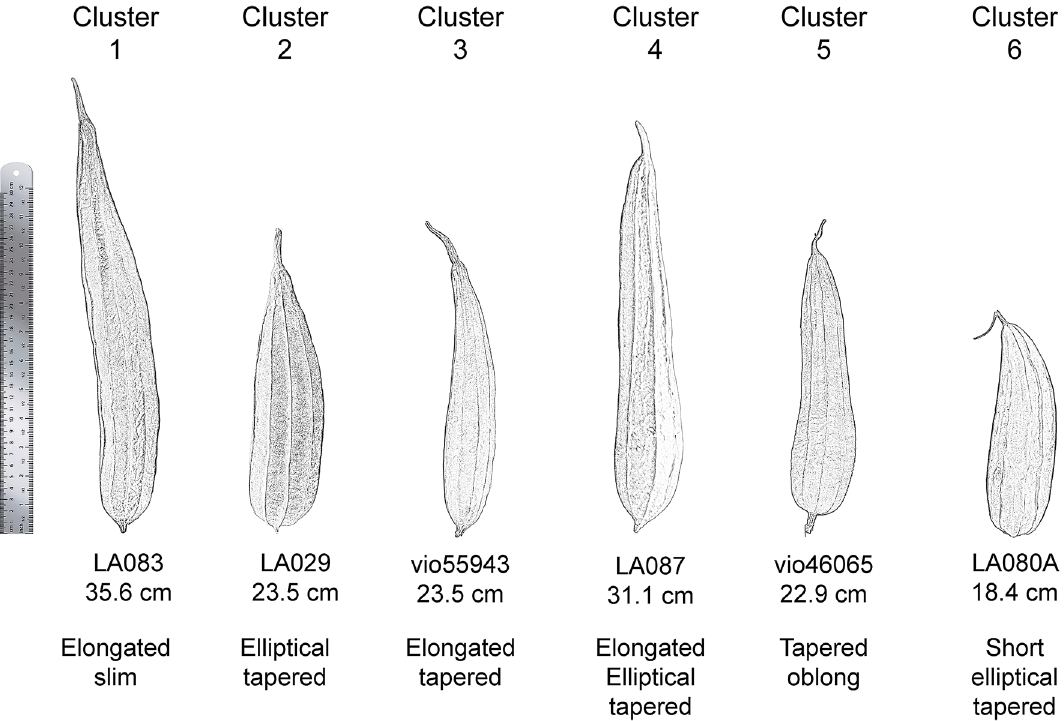
Figure 7. Luffa acutangula fruit shape. Each cluster shape is represented by an accession with the least or no